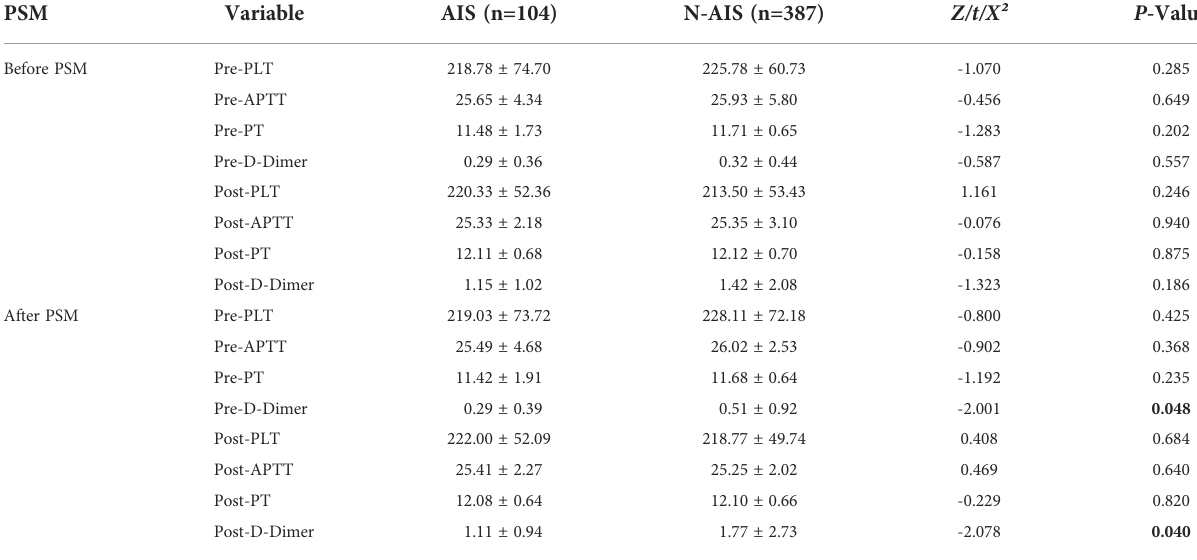
TABLE 2 Comparison of coagulation between AIS group and AD group before and after